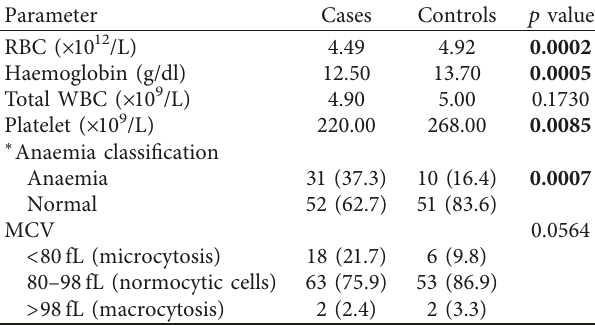
Table 2: Haematological profile of study